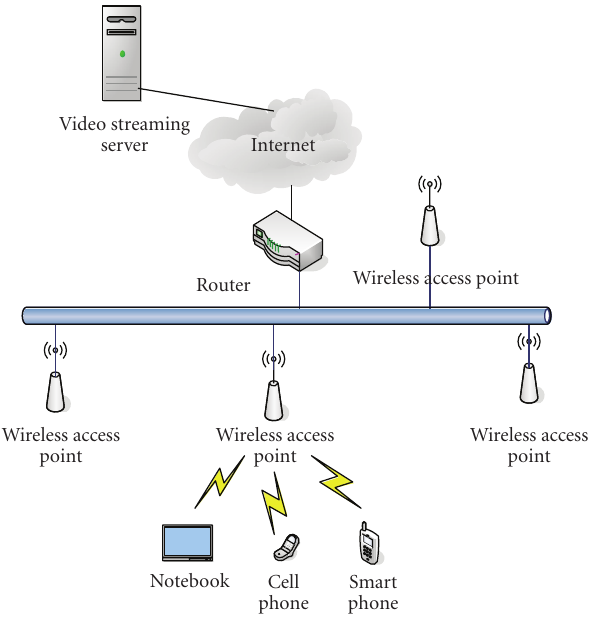
Figure 1: An example of video streaming relayed by access points.